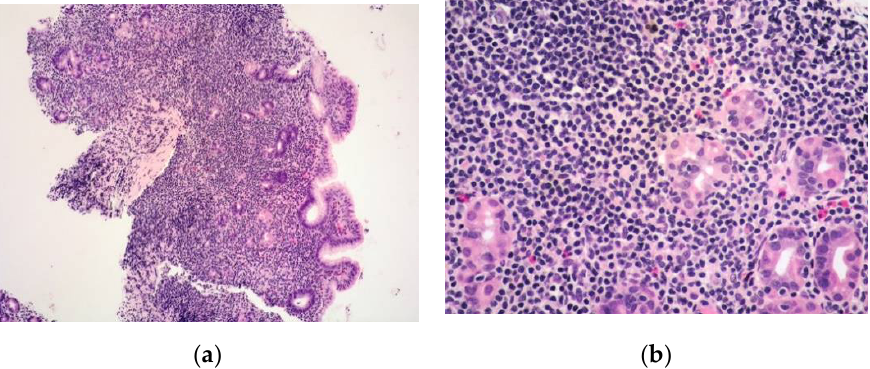
Figure 1. A gastric biopsy featuring diffuse infiltrate of the lamina propria and, focally, the submu- cosa ( a ); at higher magnification, lymphoid cells are small, monomorphic, with bland cytology ( b ). (Haematoxylin and eosin, original magnification 200× and 400×).